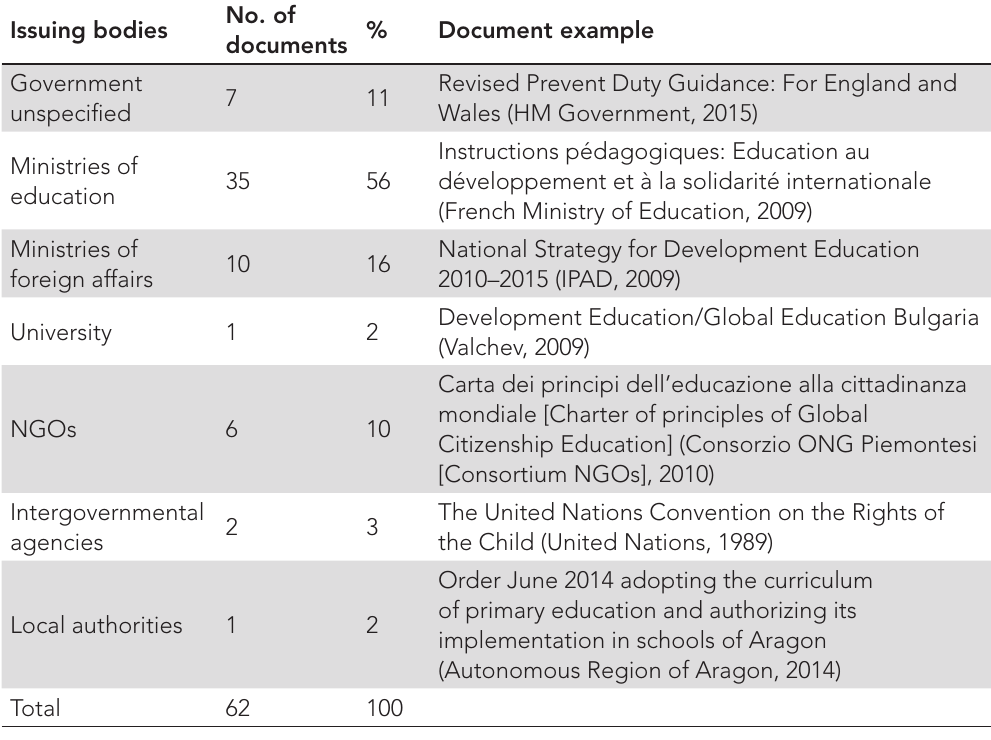
Table 1: Policy documents and main issuing bodies (as of December 2015) Issuing